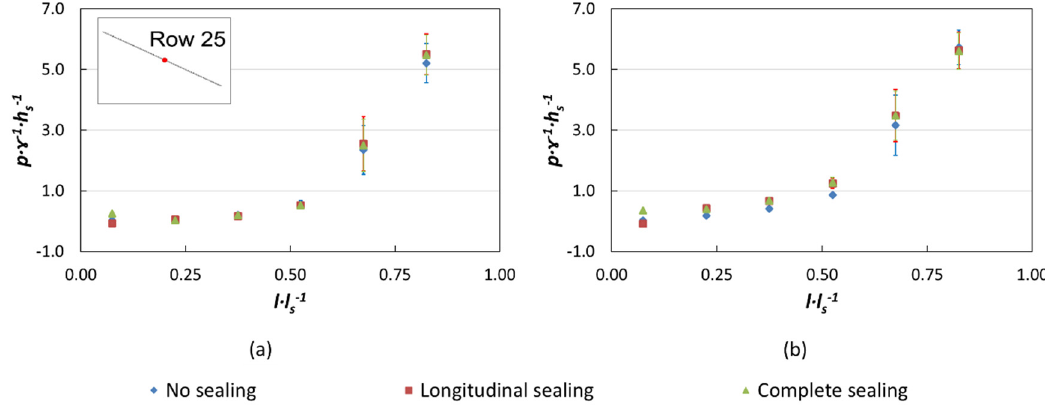
Figure 16. Pressure on the block tread of the ACUÑA block ( w 2) in row 25 in scenario d2 : without joint sealing, with longitudinal sealing and with total sealing. ( a ) 0.08 m 2 s − 1 and ( b ) 0.12 m 2 s − 1 .